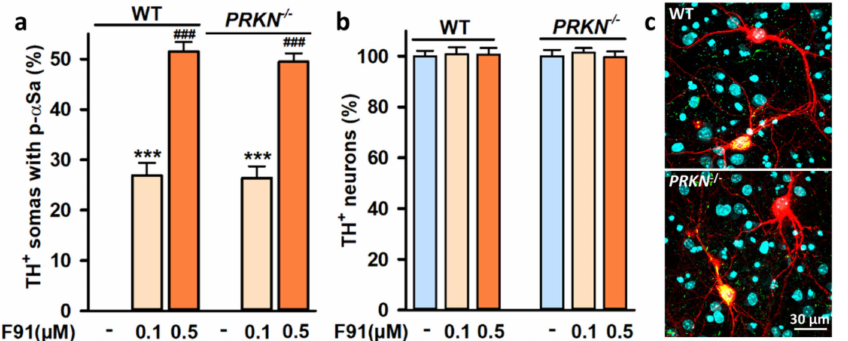
Figure 8. Impact of PRKN gene deletion on α S seeded aggregation in midbrain cultured DA neurons. ( a ) Percentage of TH + neurons with somal α Sa in three-week wild-type (WT) and PRKN − / − midbrain cultures exposed two weeks earlier to 0.1 or 0.5 µ M F91. Data are means ± SEM (8–12). *** p < 0.05, vs. controls and ### p < 0.001 vs. 0.1 µ M F91. One-way ANOVA followed by SNK test. ( b ) Survival of TH + neurons in the same culture conditions as in ( a ). Data are means ± SEM (8–12). ( c ) Representative confocal images from TH + neurons (red) in three-week wild-type and PRKN -/- midbrain cultures exposed two weeks earlier to 0.5 µ M F91. Large α Sa in DA cell bodies appear yellow after merging green (p- α S) and red (TH). Hoechst-33342 nuclear counterstaining